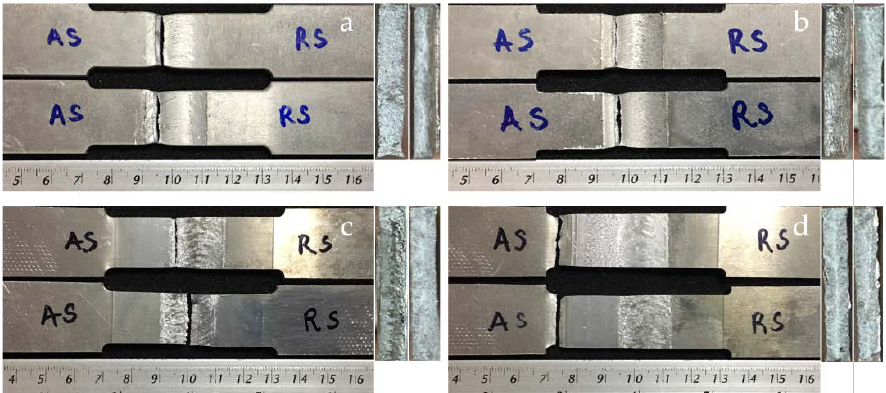
Figure 14. Stress–strain curves of the workpieces.